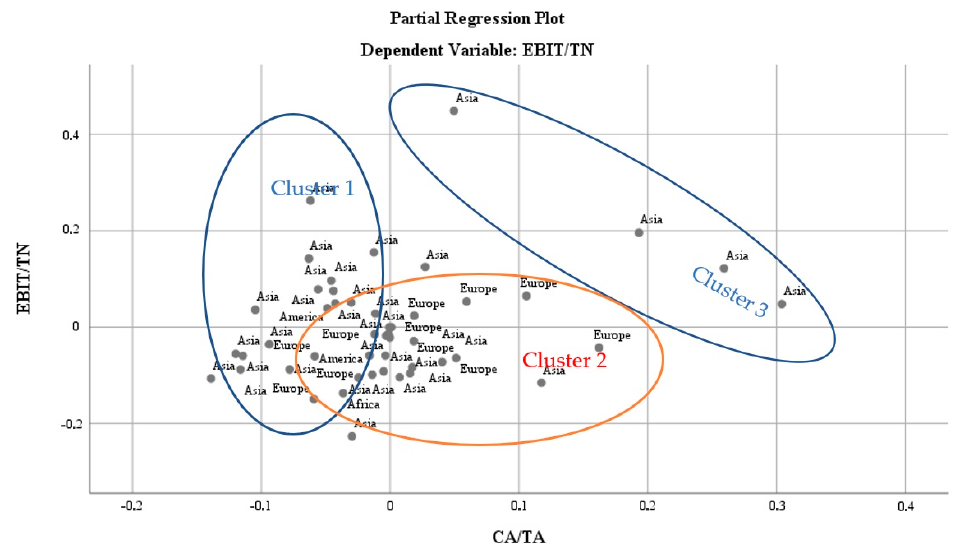
Figure 5. Distribution clusters of the value of the asset utilisation efficiency regressor on the degree of liquidity in relation to the overall economic performance rate. Returns on borrowed capital are a predominant feature of the European market (Cluster 2 Figure 6), with subunit values observed for the general model (close to 1), while for the Asian model (Cluster 1 Figure 6), the return value drops to 14% and it is an exclusive feature of centralized economies. In contrast, in the European economy, the yield is supra-unit (3.5), which means that 3.5 monetary units borrowed generate 1 unit of turnover. This is characteristic of market economies where commercial credit, the use of borrowed capital, is common financing practice (see Figure 6). This observation motivates hypothesis H2: In the overregulated regional context, the level of efficiency volatility due to uncertainty tends to be regionally uniform, and individual efficiency variability is limited and equivalently distributed based on the regulatory conditions applied in the region. The effectiveness of sustainable development and social responsibility measures is a predominant attribute of the Asian region (Cluster 2 Figure 7), where 1.5 m.u. liability produces 1 unit of turnover, twice as efficient as in the general model, where 3 m.u. liability produces 1 m.u. turnover. In the case of the European model (Cluster 1 Figure 7), there is an excessive use of liabilities (debt), which liquidates the options of economic efficiency, but in this case, we note a greater inclination towards innovation, which is likely to counterbalance the elements of efficiency lost through over-indebtedness, as it is known that there is currently a transition towards the green car industry, an aspect promoted through European sustainable development policies. We believe that this advantage will materialize in the long term with the change in the structure of the industry and will generate a superior competitive advantage to counterbalance the concentration of profile production in the Asian area (see Figure 7).